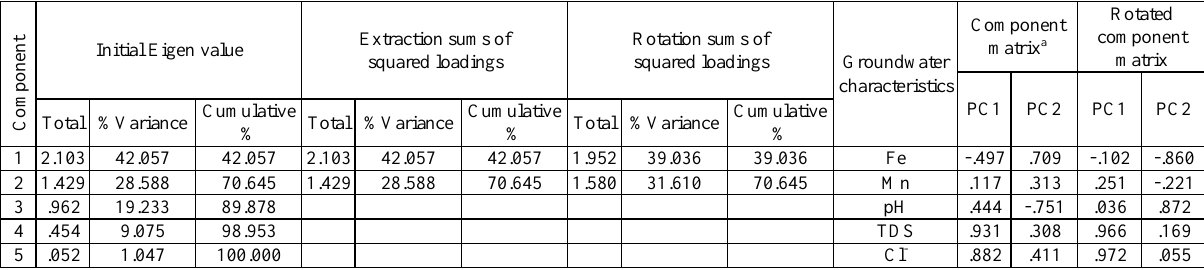
Table 5. Principal component analysis (total variance) (post-monsoon) n t Initial Eigen pon e m o C